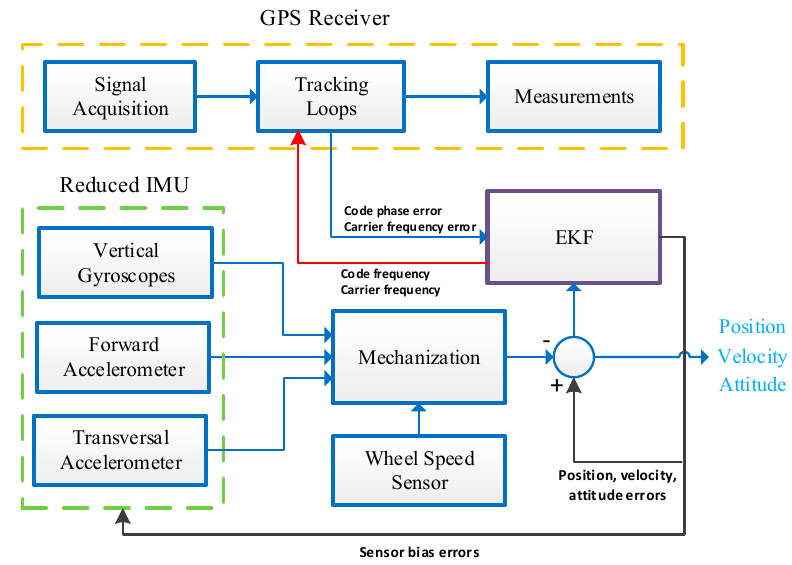
Figure 5. The Proposed Ultra Tight Integrated System.